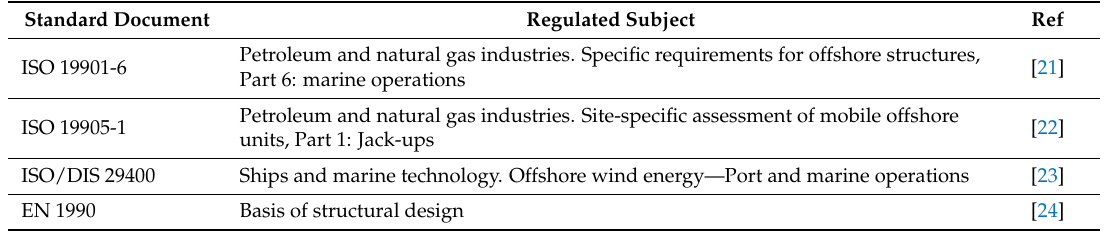
Table 2. Technical standards for the design and operation of